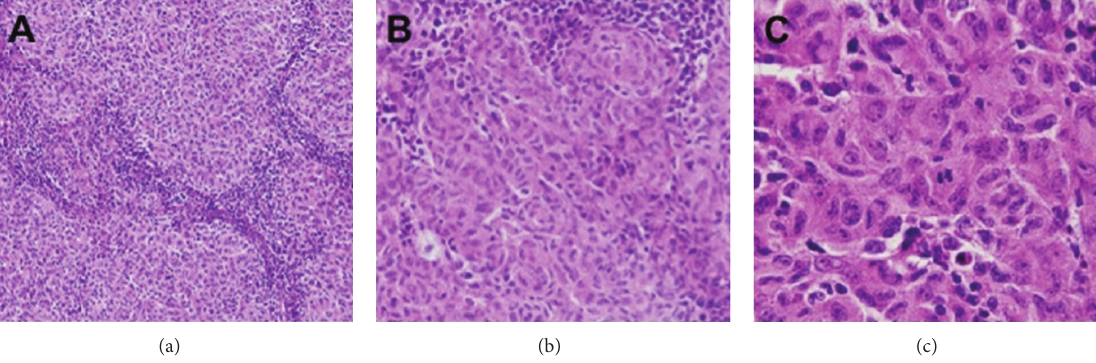
Figure 2: Histopathological aspects of interdigitating dendritic cell sarcoma revealing a growth pattern by hematoxylin and eosin staining. (a) Spindle-shaped cells make up the entire lesion, with small lymphocytes ( × 100). (b) A vaguely whorled growth pattern with abundant cytoplasmandemptynuclei( × 200).(c)Spindle-shapedcellsaredistributedindifferentpatterns:storiform,whorled,andoccasionallypalisade ( ×